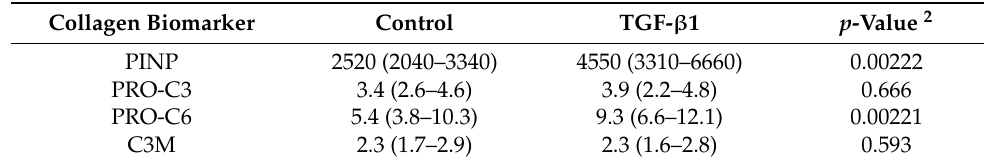
Table 3. Effect of TGF- β 1 treatment of the CoReFs on cumulative release of PINP, PRO-C3, PRO-C6, and C3M biomarkers into the media over 8 days of culture shown as ng/well 1 . Collagen